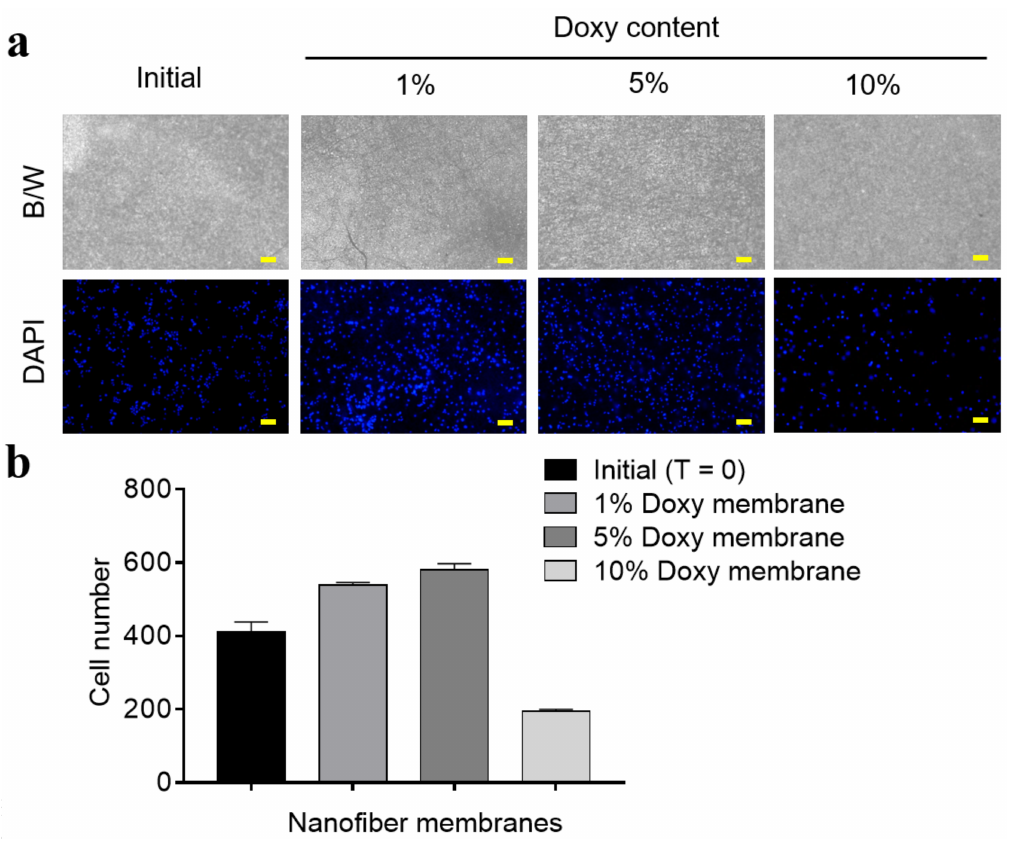
Figure 5. Cell growth on the doxy-releasing nanofiber membrane. ( a ) HT1080 mouse fibrosarcoma cells were placed on the nanofiber membrane of di ff erent doxy concentration, incubated for 72 h and stained with DAPI for fluorescence microscopy (Logos biosystems, Gyeonggi-do, Korea). ( b ) Number of HT1080 cells after 72 h of incubation on the top of the doxy-eluting membrane. Number of cells was calculated using Image J software. Error bars indicate SEM ( n = 3). The scale bar represents 50 µ